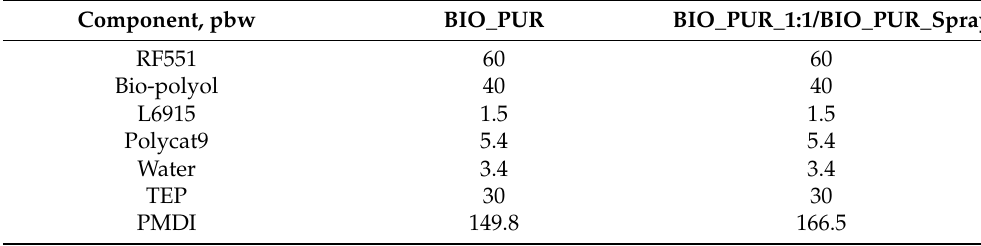
Table 4. Formulations of foam materials, in parts by weight